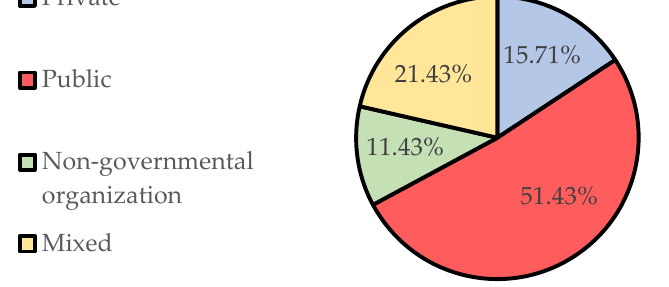
Figure 2. The structure of ownership form among ERIH sites.